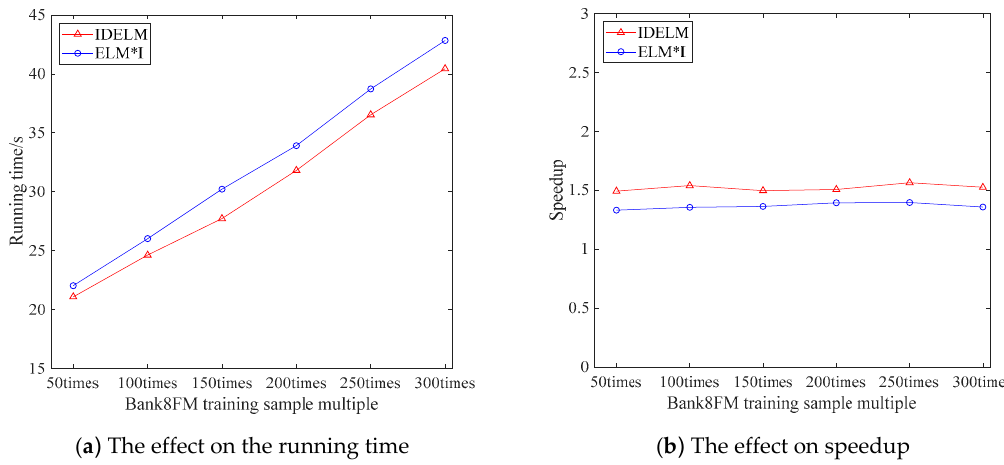
Figure 3. The effect of training samples on the running time (a) and speedup (b) of the